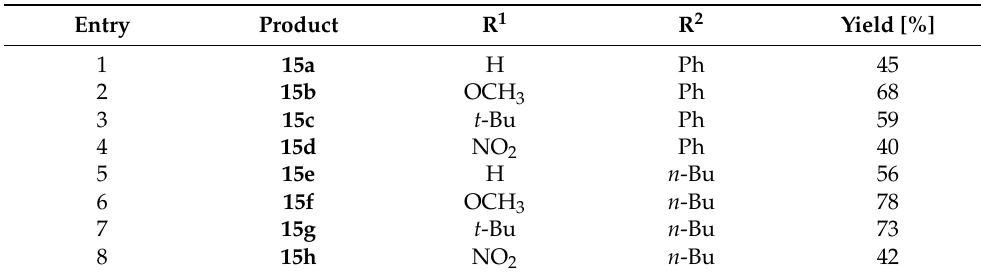
Table 2. The yield of the reaction for the preparation of s -tetrazine derivatives directly conjugated to the 4 H -1,2,4-triazole ring ( 15a – h